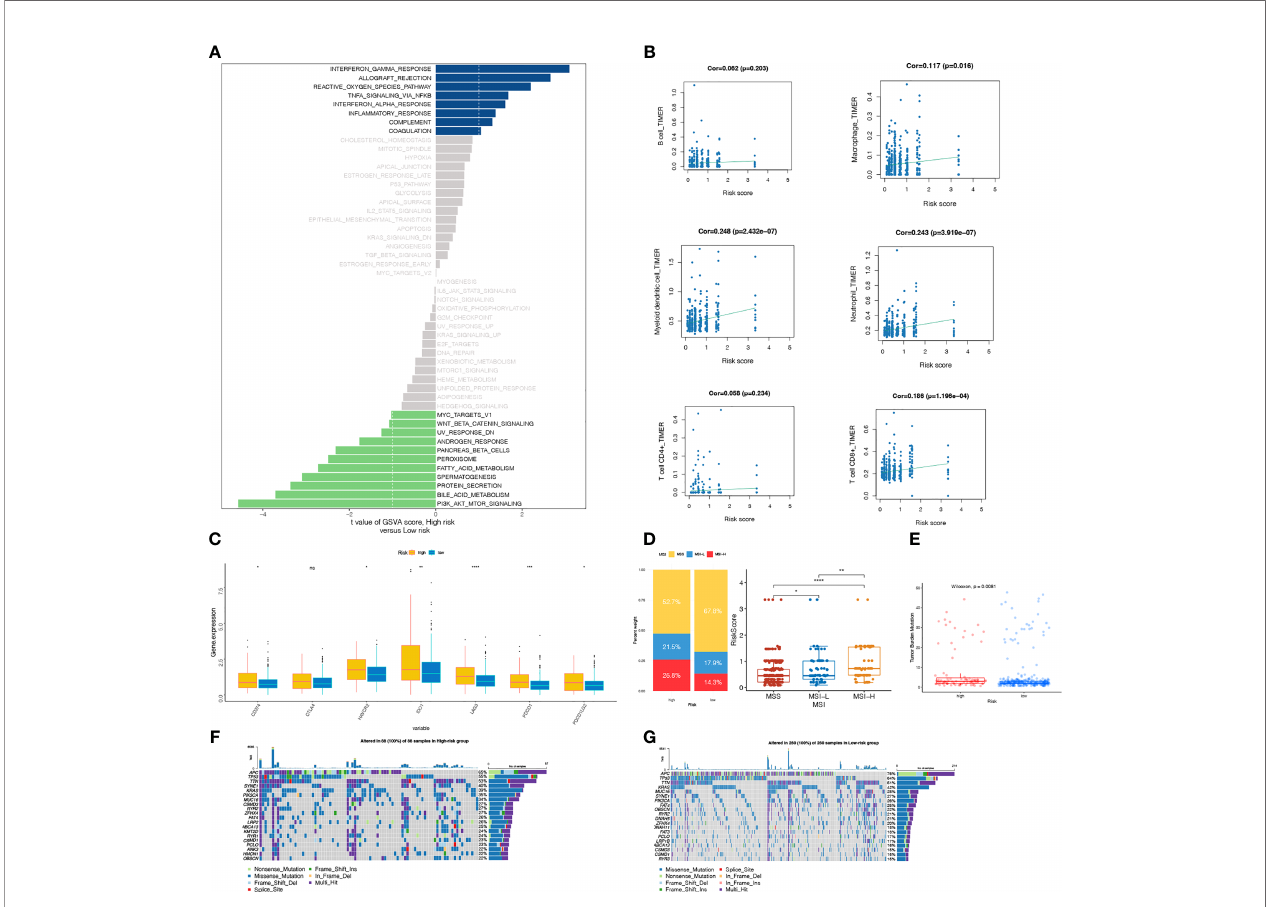
FIGURE 6 | (A) GSVA analysis (B) Spearman correlation analysis between the signature and six immune cells (B cell, Macrophage, Myeloid dendritic cell, Neutrophil cell, T cell CD4+ T cell CD8+) ; (C) The comparison of PDCDl, PDCD1LG2, LAG3, HAVCR2, CD274,IDO1 and CTLA-4 expression levels between high-risk and low- groups; (D) Relationships between risk score and MSI. (E) Relationships between risk score and TMB. (F, G) The waterfall plot of somatic mutation landscape between two risk groups, ranked by top 20 frequently mutated